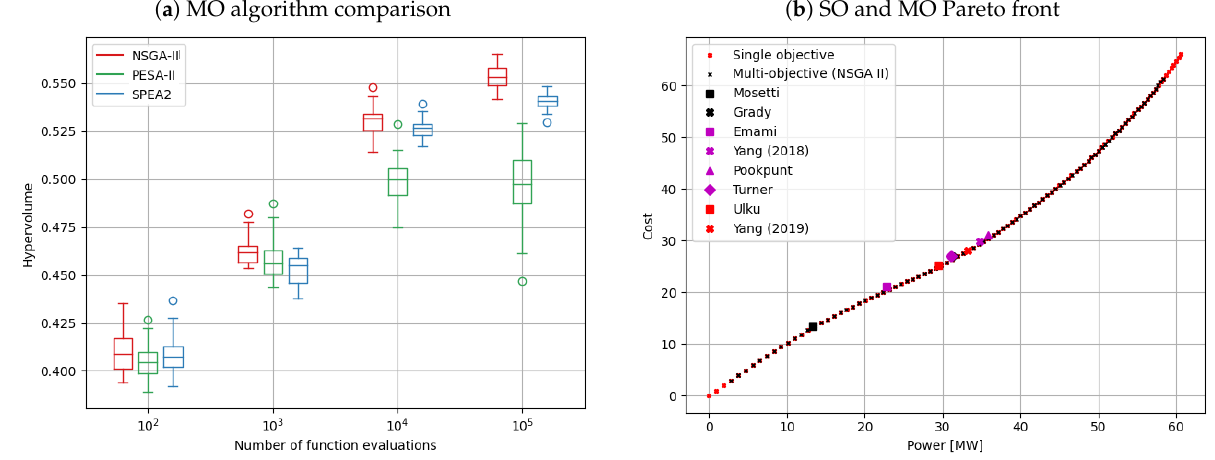
Figure 19. MO algorithm performance and Pareto front for case